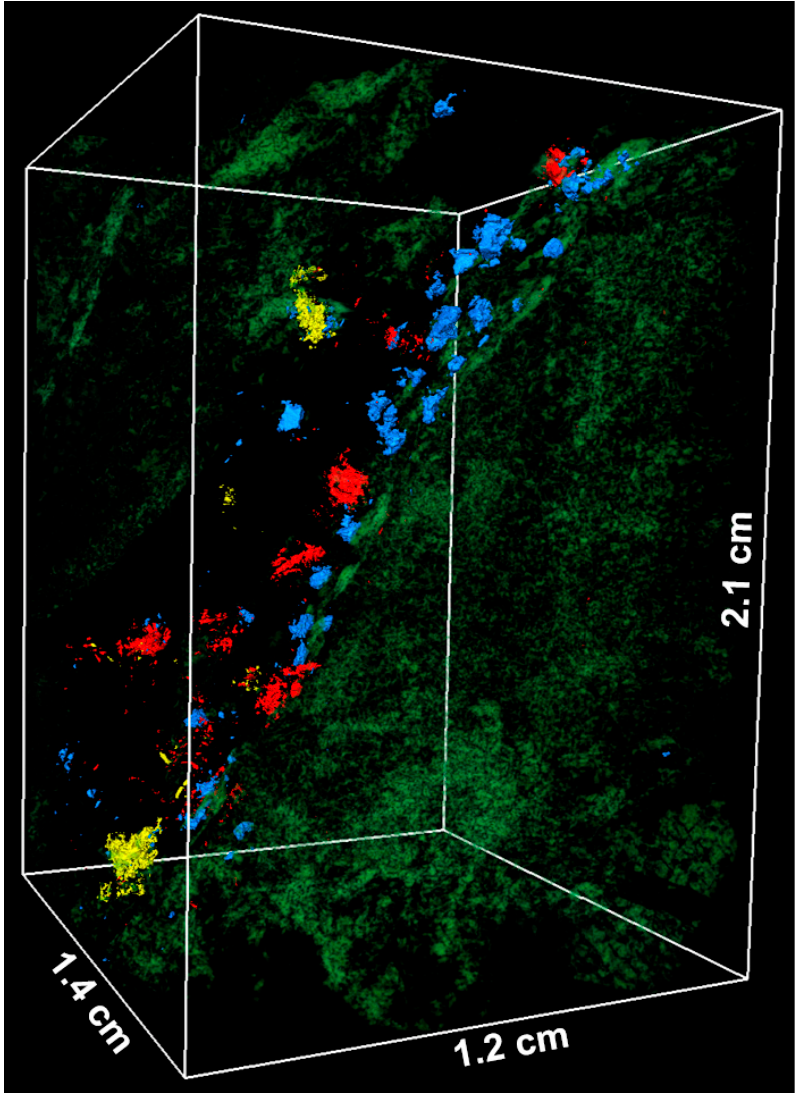
Figure 6. 3D image of a subvolume of a vein rich in heavy elements classified using a combination of traditional CT and sp-CT. Light phases (e.g., silicates and carbonates) are set transparent, green denotes light sulphides (e.g., pyrite), yellow denotes gold grains, red denotes boulangerite grains, blue denotes tetrahedrite grains.